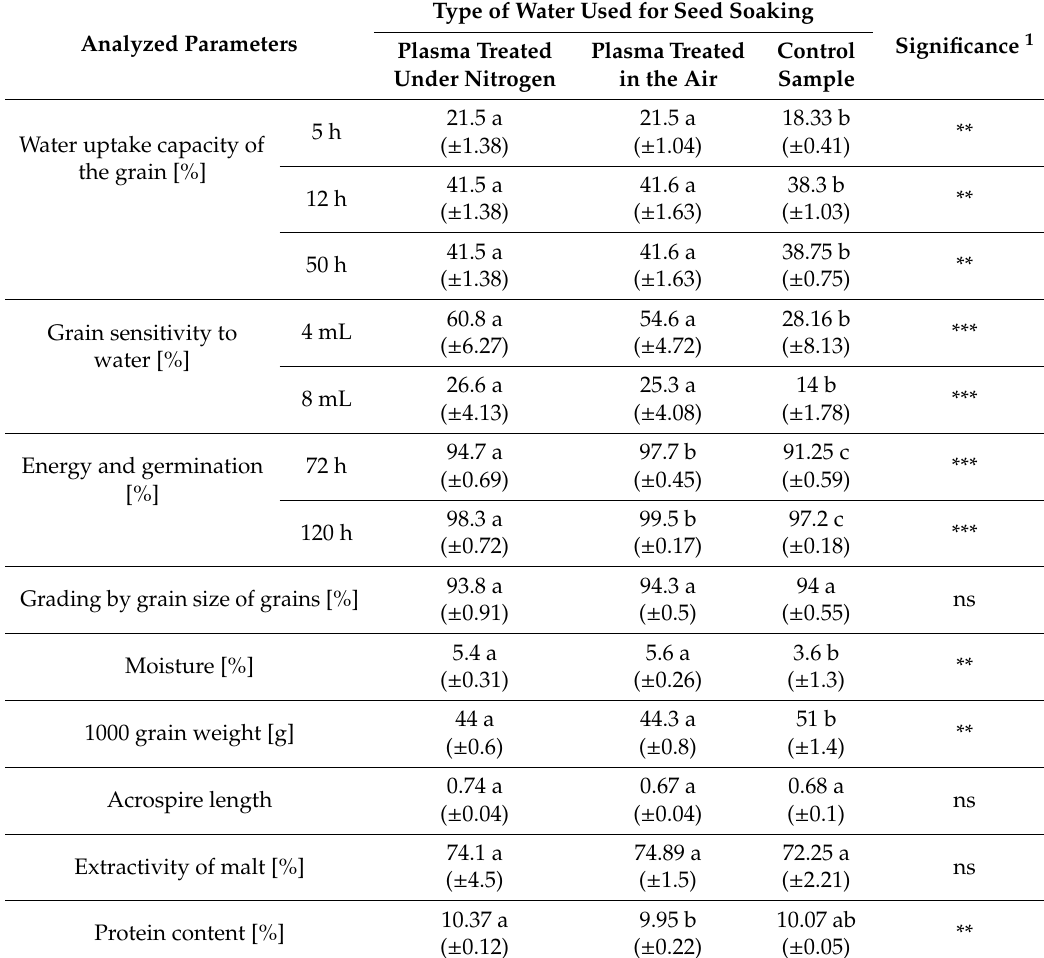
Table 2. The quality parameters of barley and the obtained